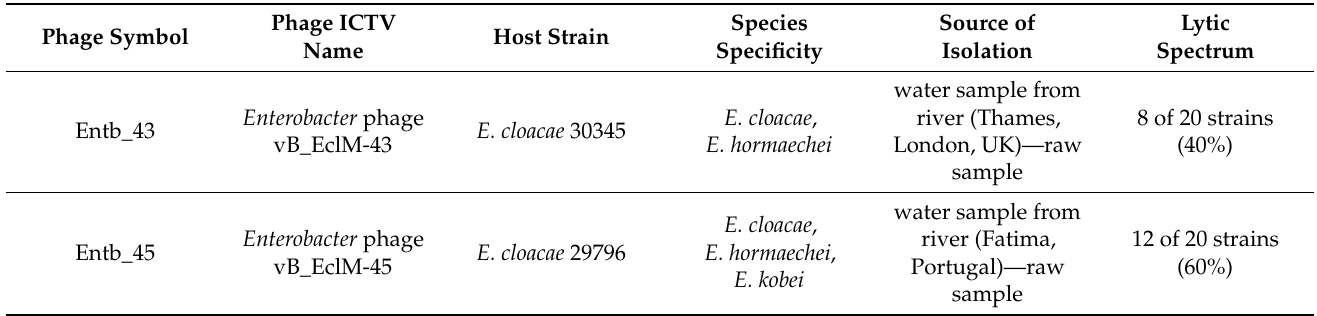
Table 3. Characterization of the newly isolated Enterobacter -specific bacteriophages. Phage